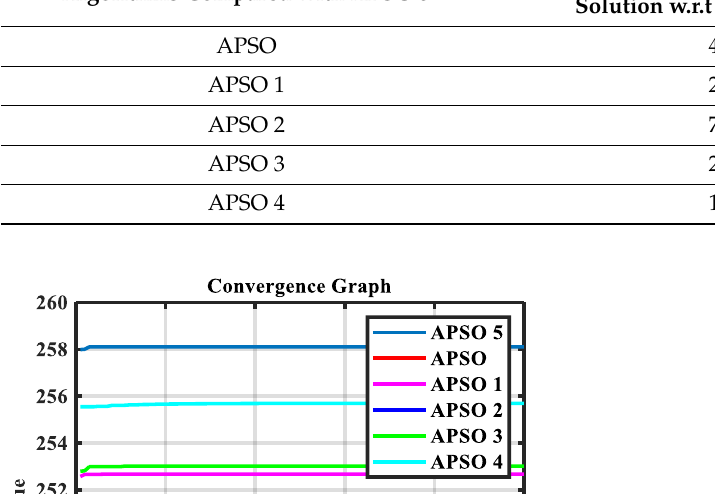
Table 16. Comparison of the APSO 5 solution with other algorithms regarding percentage increase for the 1000-PHEV dataset.